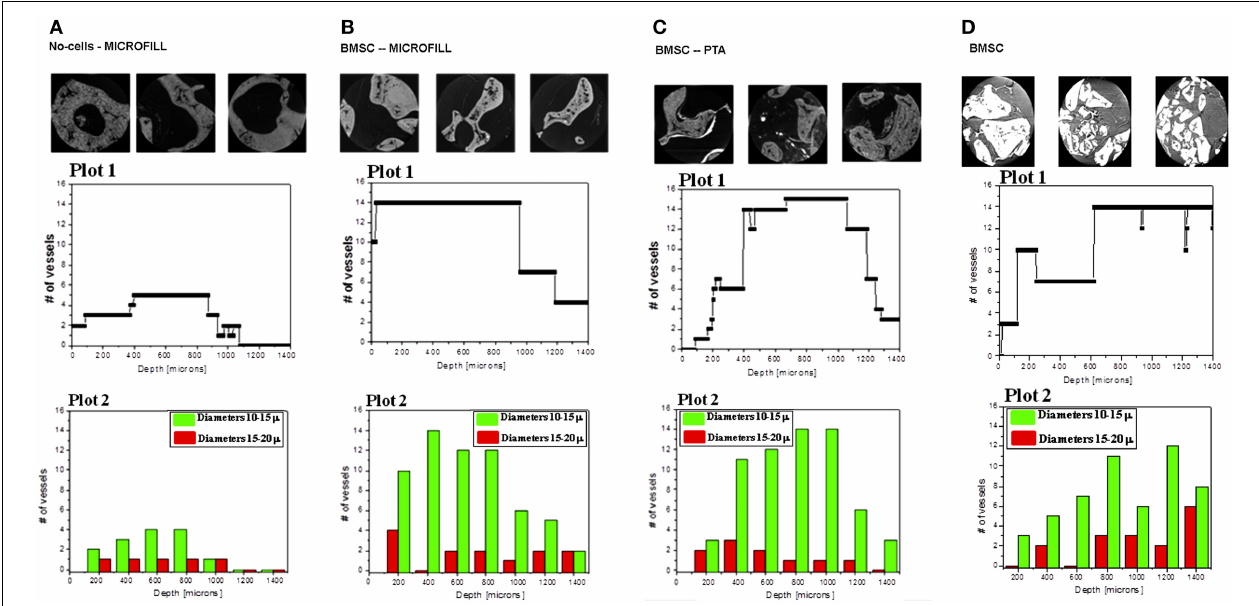
FIGURE 3 | Quantitative analysis of the A, B, C, and D samples . Plots 1 show the number of vessels crossing the samples at the different depth inside the volume. For each sample, the three pictures above the plot 1, are the tomography images of the upper, central and top parts of the sample. Plots 2 report the spatial distribution of large vessels in dark (red on line) and small vessels in gray (green on